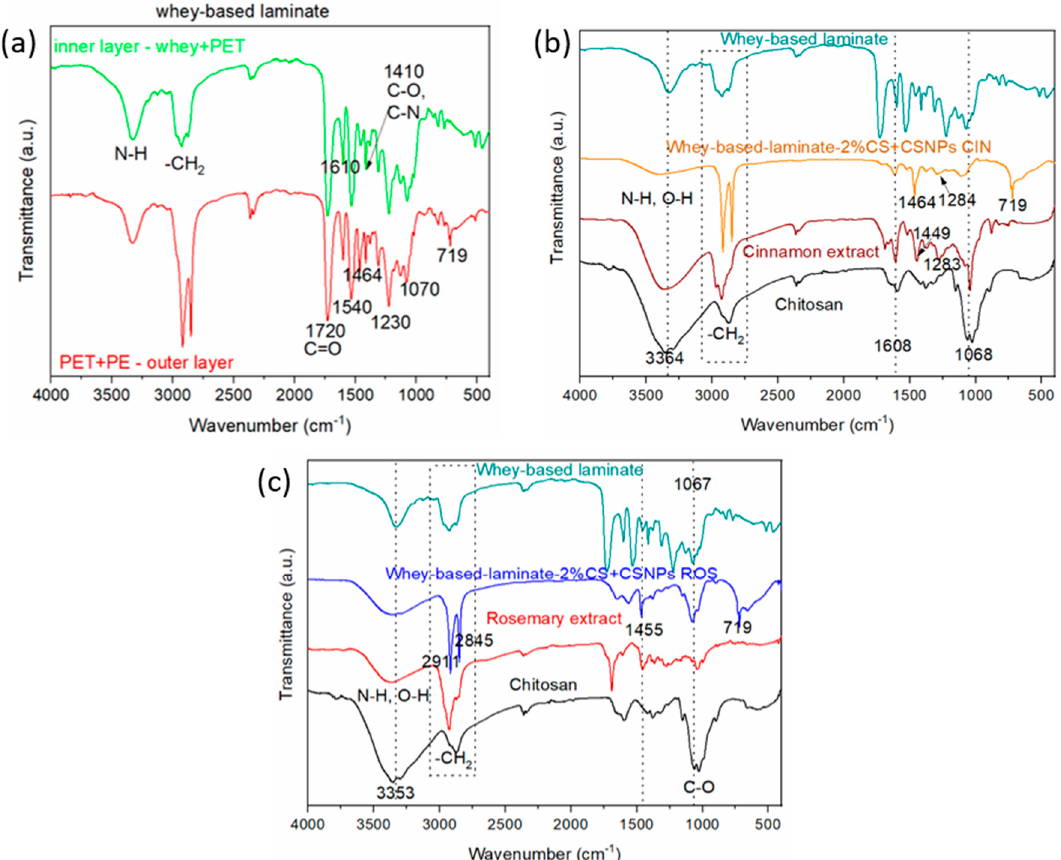
Figure 3. Attenuated Total Reflection–Fourier Transform Infrared (ATR-FTIR) spectra of different layers of whey-based laminate film structure is shown in ( a ); IR spectra of pristine, extracts, chitosan and the modified whey-based laminate film for the 2%CS+CSNPs CIN is shown in ( b ); and the whey-based laminate film with the deposited 2%CS+CSNPs ROS is shown in ( c ).